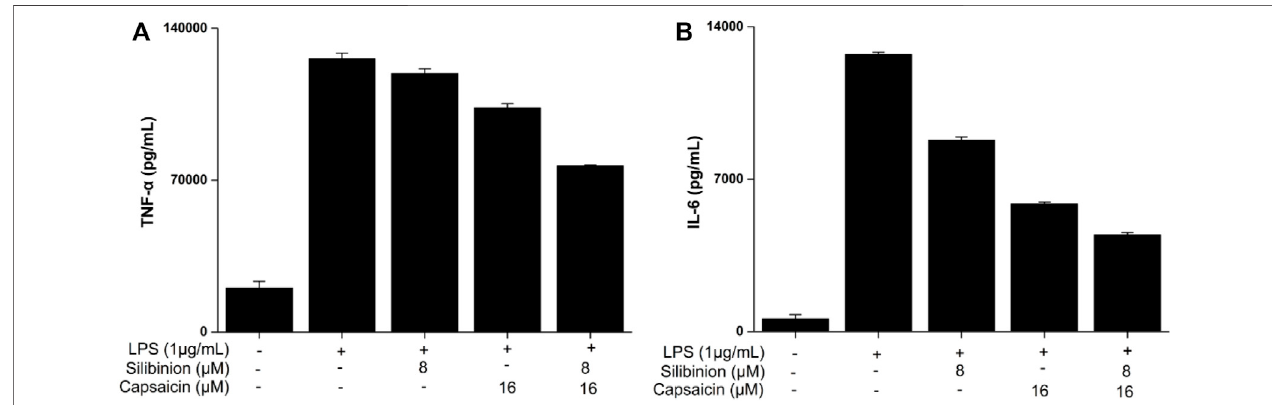
FIGURE 4 | Effect of silibinin and capsaicin on LPS-induced TNF- α (A) and IL-6 (B) . After being plated into 24-well plates for 24 h and the cells were treated with silibinin and/or capsaicin for 2 h and subsequently induced with LPS (1 μ g/ml) for 24 h. Then, the supernatant was detected for TNF- α and IL-6 levels according to the manufacturer ’ s